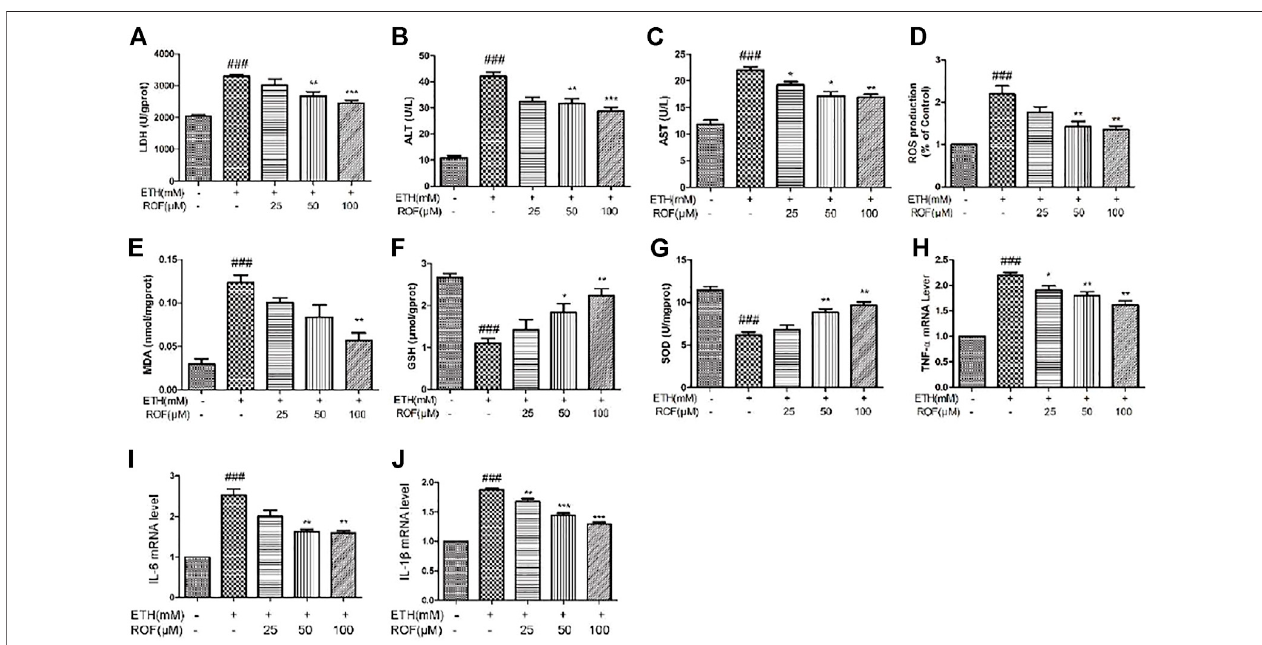
FIGURE 5 | Effect of ROF on the production of LDH (A) , ALT (B) , AST (C) , ROS (D) , MDA (E) , GSH (F) , and SOD (G) in ETH-treated hepatocytes. The cells were exposed to ETH (200 mm) and ETH + ROF (25, 50, 100 μ M) for 24 h. The expression levels of TNF- α (H) , IL-6 (I) , and IL-1 β (J) in LO2 cells. Mean ± SEM ( n = 3 – 4). * p